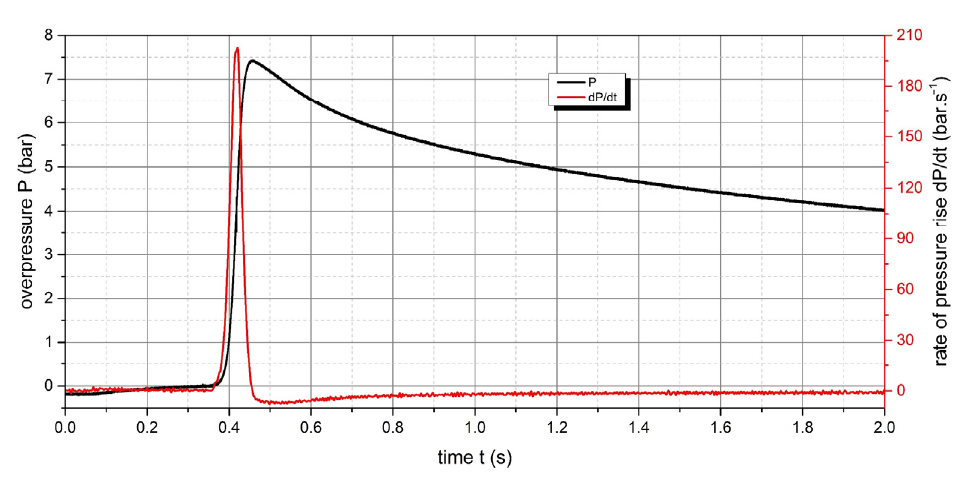
Figure 7. Overpressure P and rate of pressure rise dP/dt of 250 g·m − 3 Lycopodium clavatum powder ignited by Igniter 2 (shelf life more than 2 years).